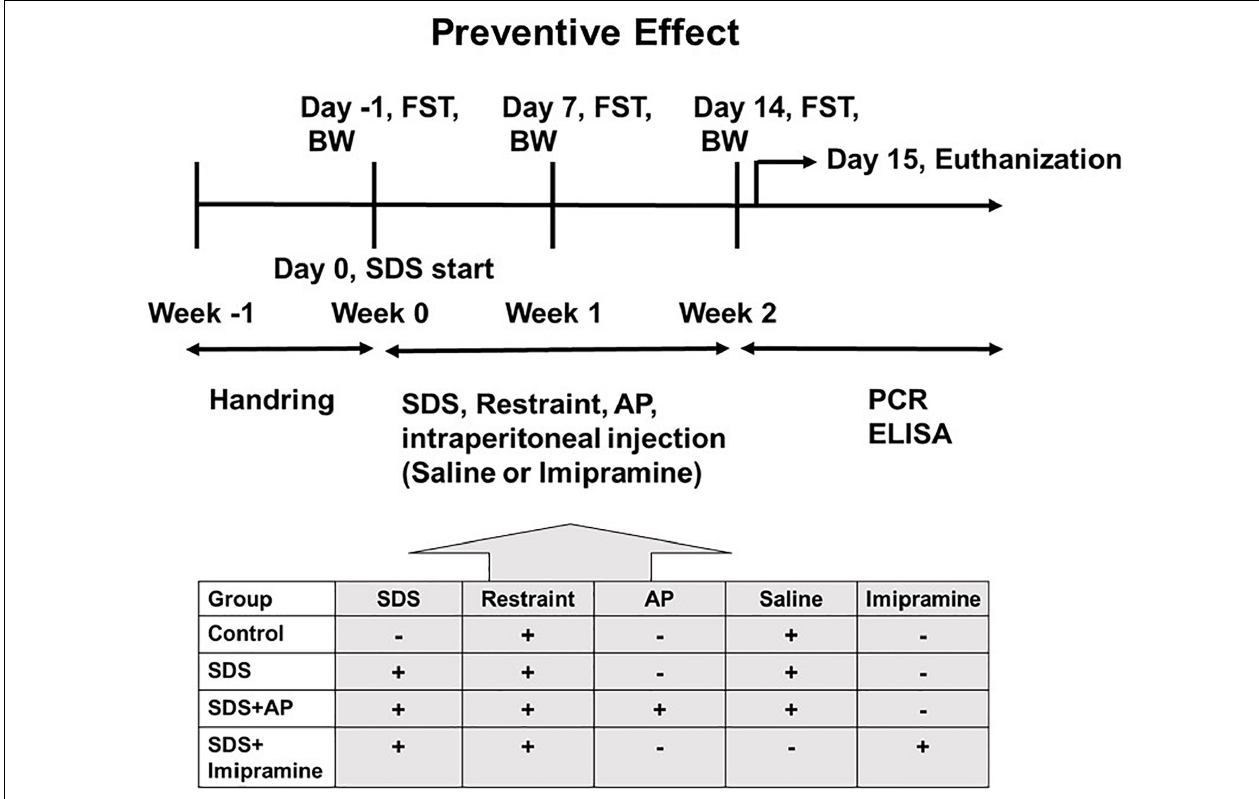
FIGURE 1 | The schedule of the “preventive effect” experiment. The timeline of the procedures for the “preventive” group conditions. AP, acupuncture; BW, body weight; ELISA: enzyme-linked immuno sorbent assay; FST, forced swimming test; PCR, polymerase chain reaction; SDS, social defeat stress.